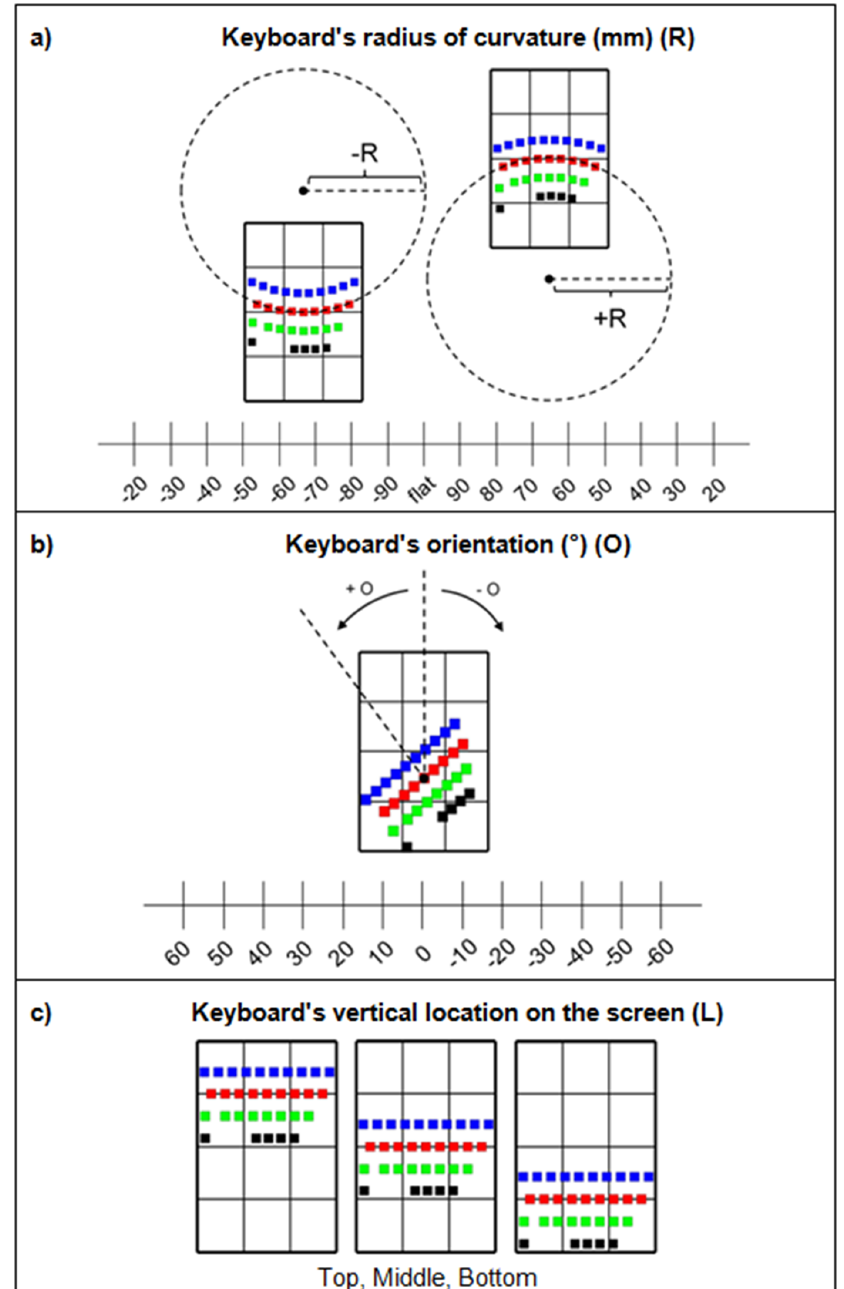
Figure 3. Design parameters: (a) the keyboard’s radius of curvature (R) has 17 levels; (b) the keyboard’s orientation with respect to horizontal (O) has 13 levels; (c) the keyboard’s location on the screen has 3